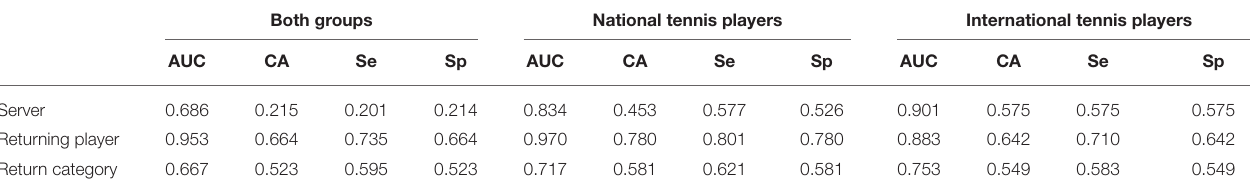
TABLE 2 | Performance of different classification